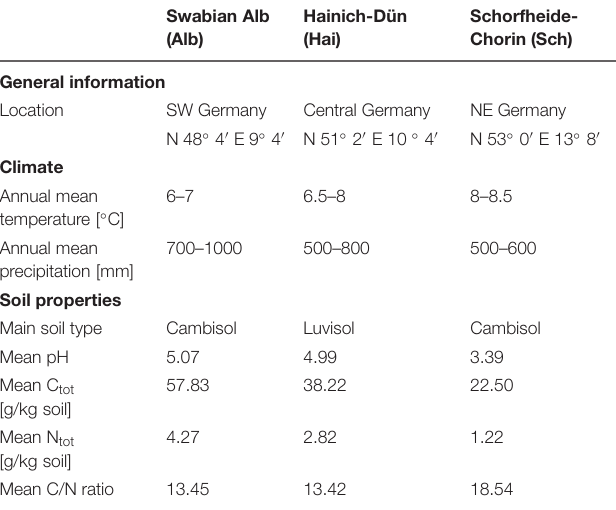
TABLE 1 | Overview of the three study sites including: information about geography, climate, soil properties (Fischer et al., 2010; Solly et al., 2014); soil properties display the mean values (see section “Basic soil